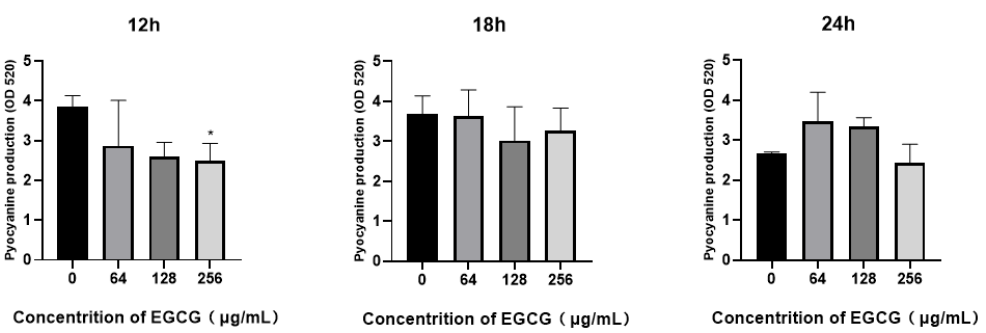
Figure 4. The inhibition of EGCG on P. aeruginosa pyocyanin production at 12 h, 18 h, and 24 h. (All data are representative data are representative of three independent experiments performed in triplicate and expressed as of three independent experiments performed in triplicate and expressed as the mean ± SD values in each bar. * p < 0.05. the mean ± SD values in each bar. * p <